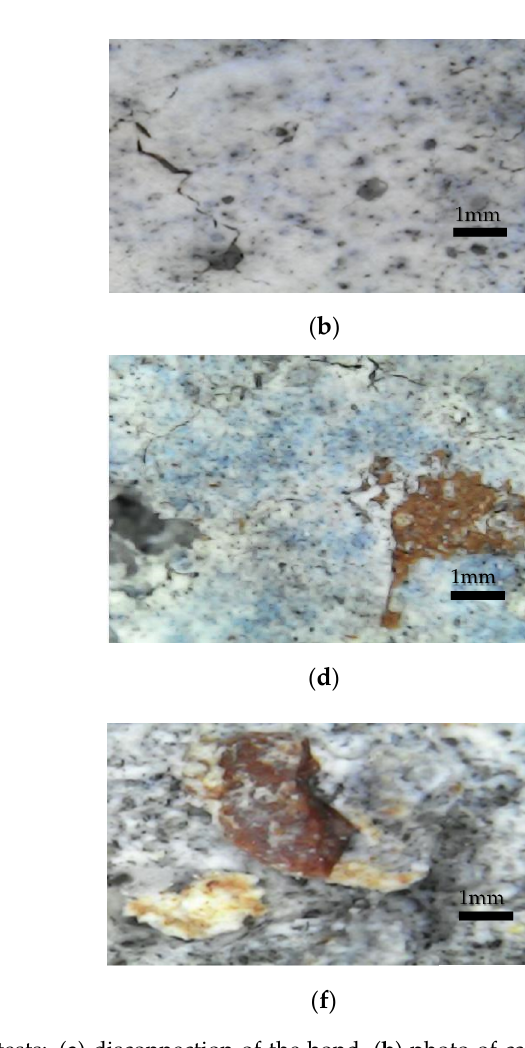
Figure 5. Typical failure modes in pull-out tests: ( a ) disconnection of the bond, ( b ) photo of case ( a ) magnified, ( c ) the specimen broke in its own section ( d ) photo of case ( c ) magnified, ( e ) fracture of the bond material itself, ( f ) photo of case ( e ) magnified.